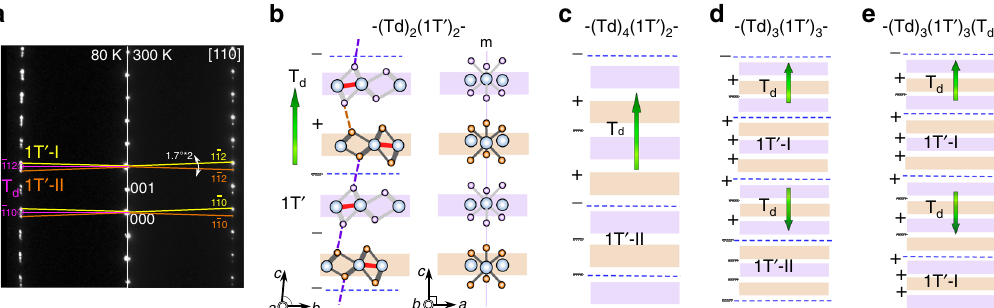
Fig. 3 SAED pattern of MoTe 2 and the schematics of − (T d ) m (1T´) n − 1T´/Td superlattice along the c axis. a The presence of 1T´-I, 1T´-II, twins and the T d phase are indicated with yellow, orange and pink straight lines. Though 1T´ and T d show the same extinction rules along [110], the orthogonal and non- orthogonal angles between ( (cid:1) 110) and ( (cid:1) 112) planes indicated by pink, yellow and orange lines unambiguously can be the fi ngerprint of T d , 1T´-I, and 1T´-II domains. b The smallest − (T d ) 2 (1T´) 2 − periodicity by symmetry. The con fi guration of + M − P + M + P + corresponds to 4 layers, namely ~2.8 nm. Purple and orange blocks represent M and P layers, respectively. Blue dashed lines mark the phase DWs. The mirror symmetry, perpendicular to the a axis, can be seen along [010] projection (unique axis a , when b > a ). Experimentally, the thinnest periodicity is found to be 6 layers. c Six layers consist of either − (T − , − (T − or − (T − . Considering the T d ) 4 (1T´) 2 d ) 2 (1T´) 4 d ) 3 (1T´) 3 d phase as the ground state at 80 K and the lattice mismatch as explained